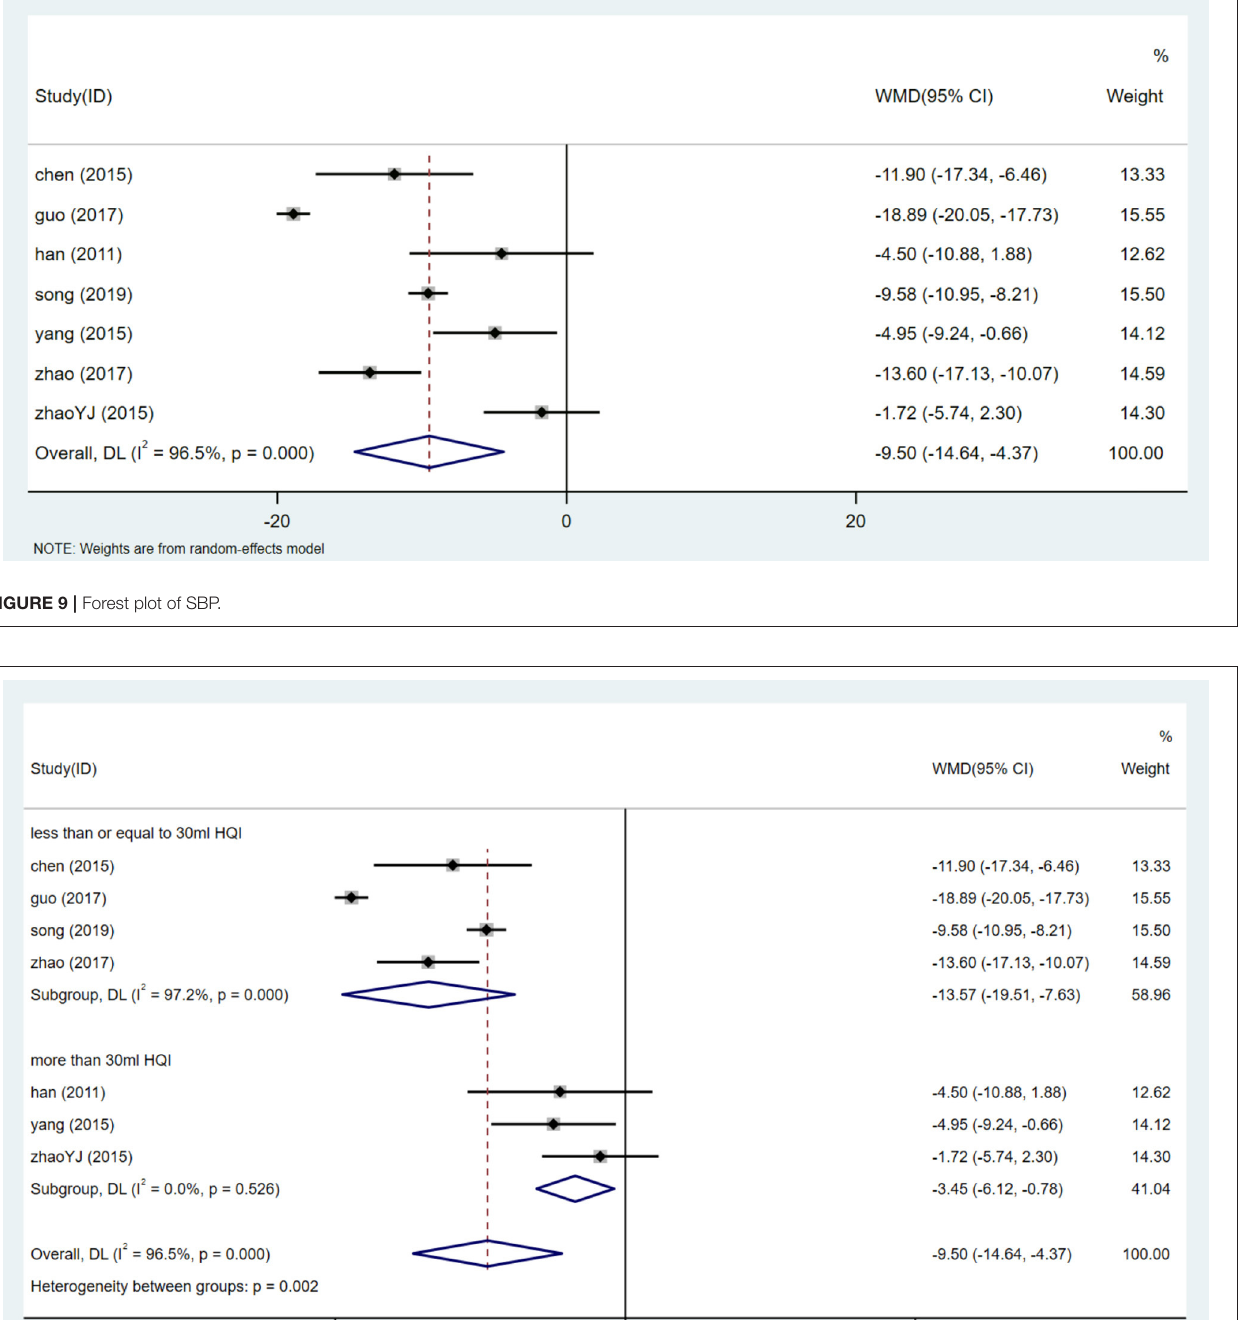
95% CI ( − 7.033, − 4.213), P = 0.000, I 2 = 18.2%] ( Figure 12 , Supplementary Figure 22 ) both reduce heterogeneity, and the results were statistically significant ( P = 0.010). There was